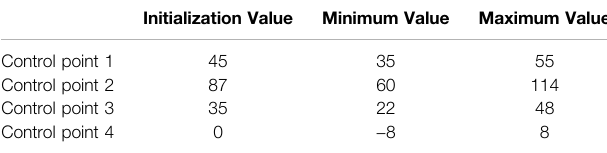
TABLE 2 | X-coordinate optimization range of control points (mm).